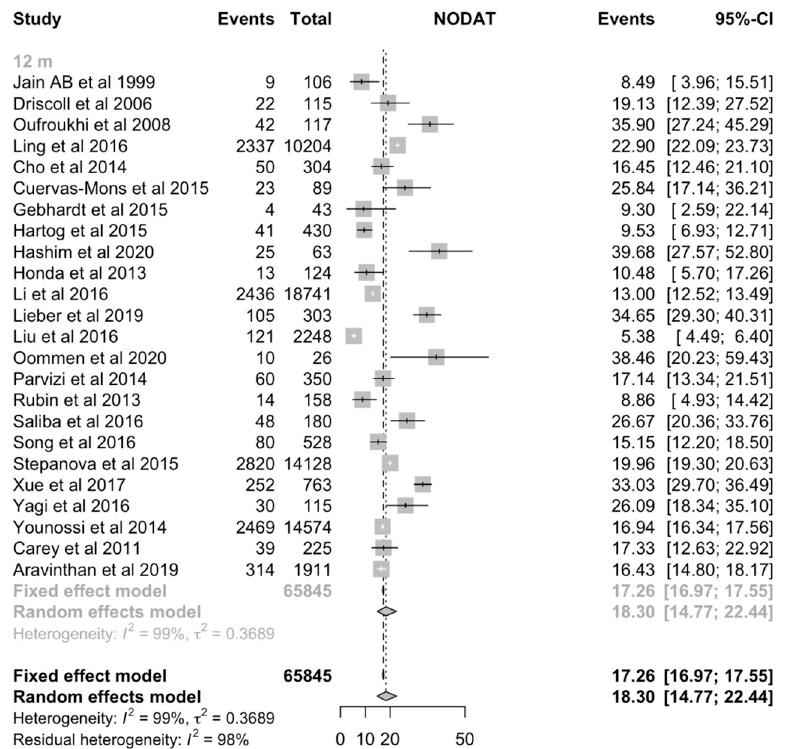
Figure 3. Incidence of New-Onset Diabetes after Transplantation (NODAT) at 1-year after Liver Transplantation. CI = Confidence interval.